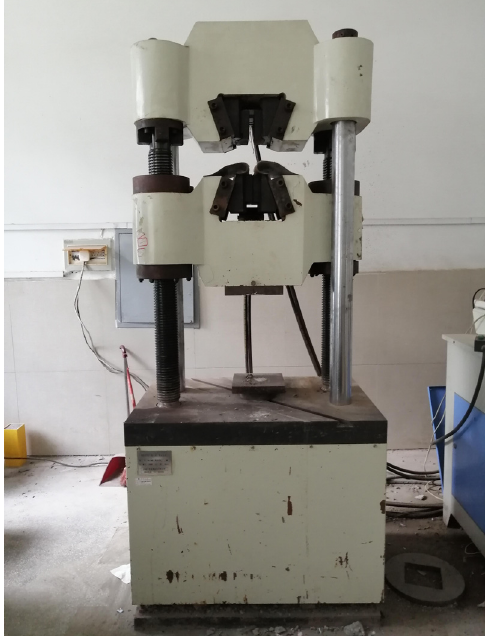
Figure 4: Loading